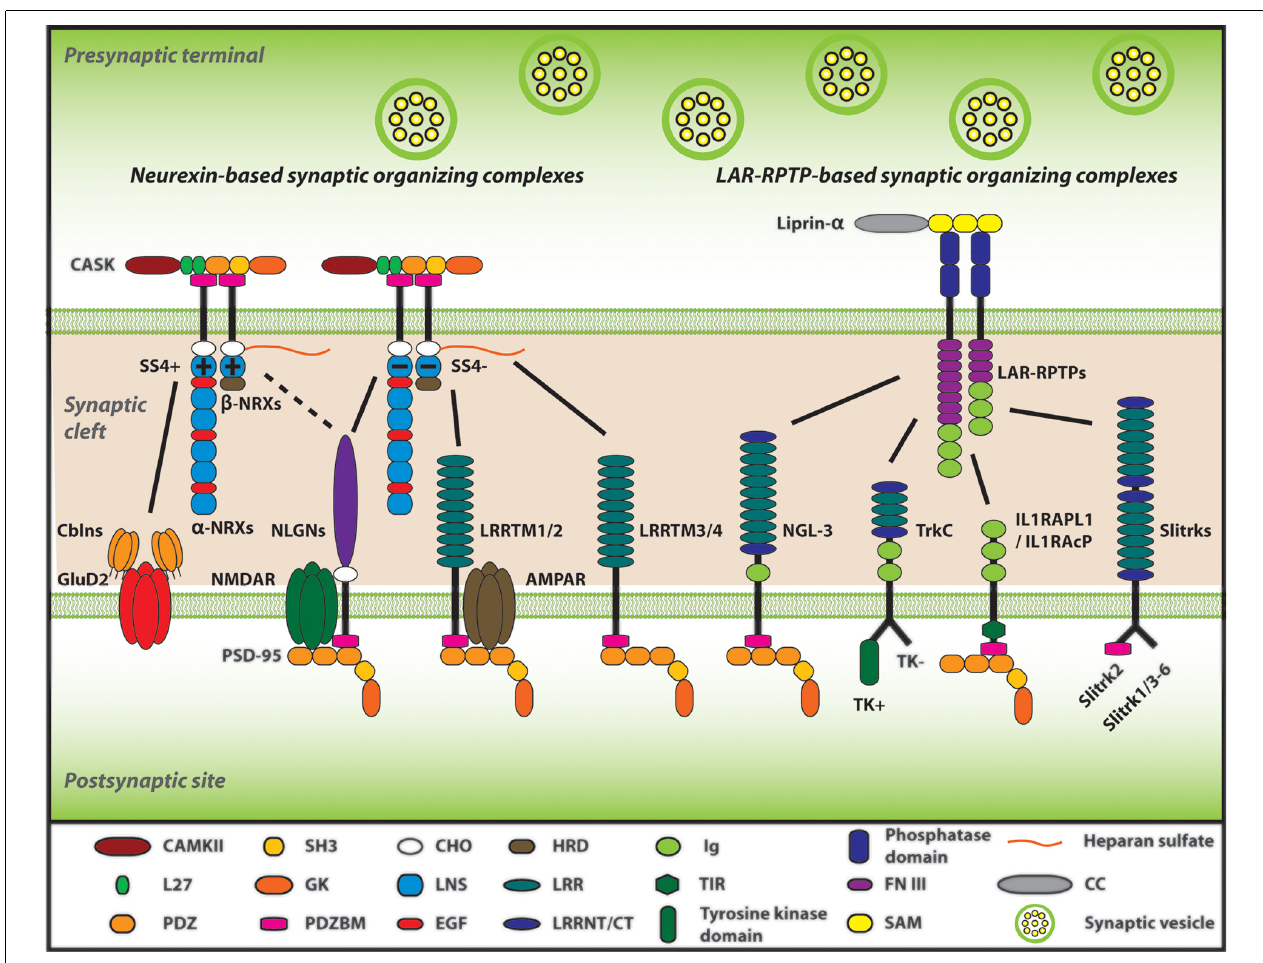
FIGURE 1 | Neurexins (NRXs) and Leukocyte common antigen-related receptor protein tyrosine phosphatases (LAR-RPTPs) serve as presynaptic hubs to orchestrate synapse organization. The trans-interaction between pre- and post-synaptic organizers generate retrograde and anterograde “synaptogenic” signals through the synaptic cleft, resulting in the presynaptic organization, including synaptic vesicles clustering, and in the postsynaptic organization, encompassing the recruitment of neurotransmitter receptors [e.g., AMPA-type and NMDA-type glutamate receptor (AMPAR and NMDAR)] and scaffold proteins (e.g., PSD-95). As presynaptic molecular hubs, NRXs and LAR-RPTPs trans-synaptically interact with multiple specific postsynaptic organizers, for instance, NRXs-neuroligins (NLGNs), NRXs-leucine-rich-repeat transmembrane neuronal proteins (LRRTMs), PTP σ -neurotrophin receptor tropomyosin-related kinase C (TrkC), PTP σ / δ -Slit and